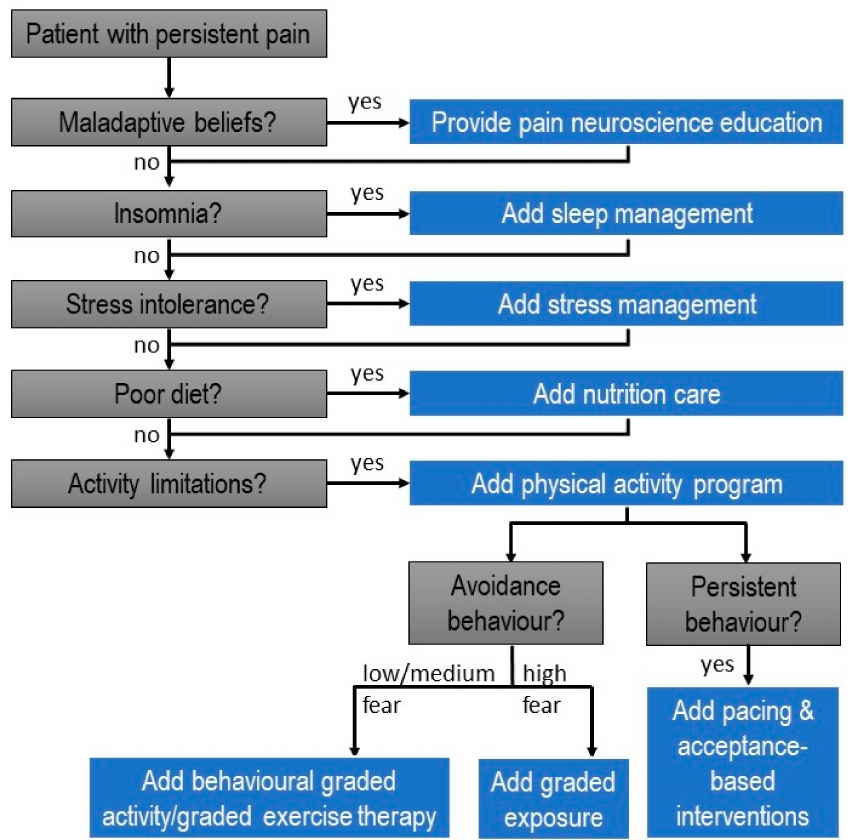
Figure 1. Towards precision medicine for chronic pain: clinical decision-making tree for providing an individually tailored lifestyle approach for patients with chronic